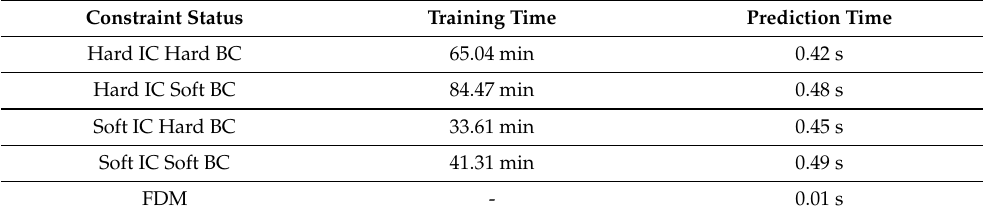
Table 5. Execution times for each of the constraint statuses with their best-tested set of